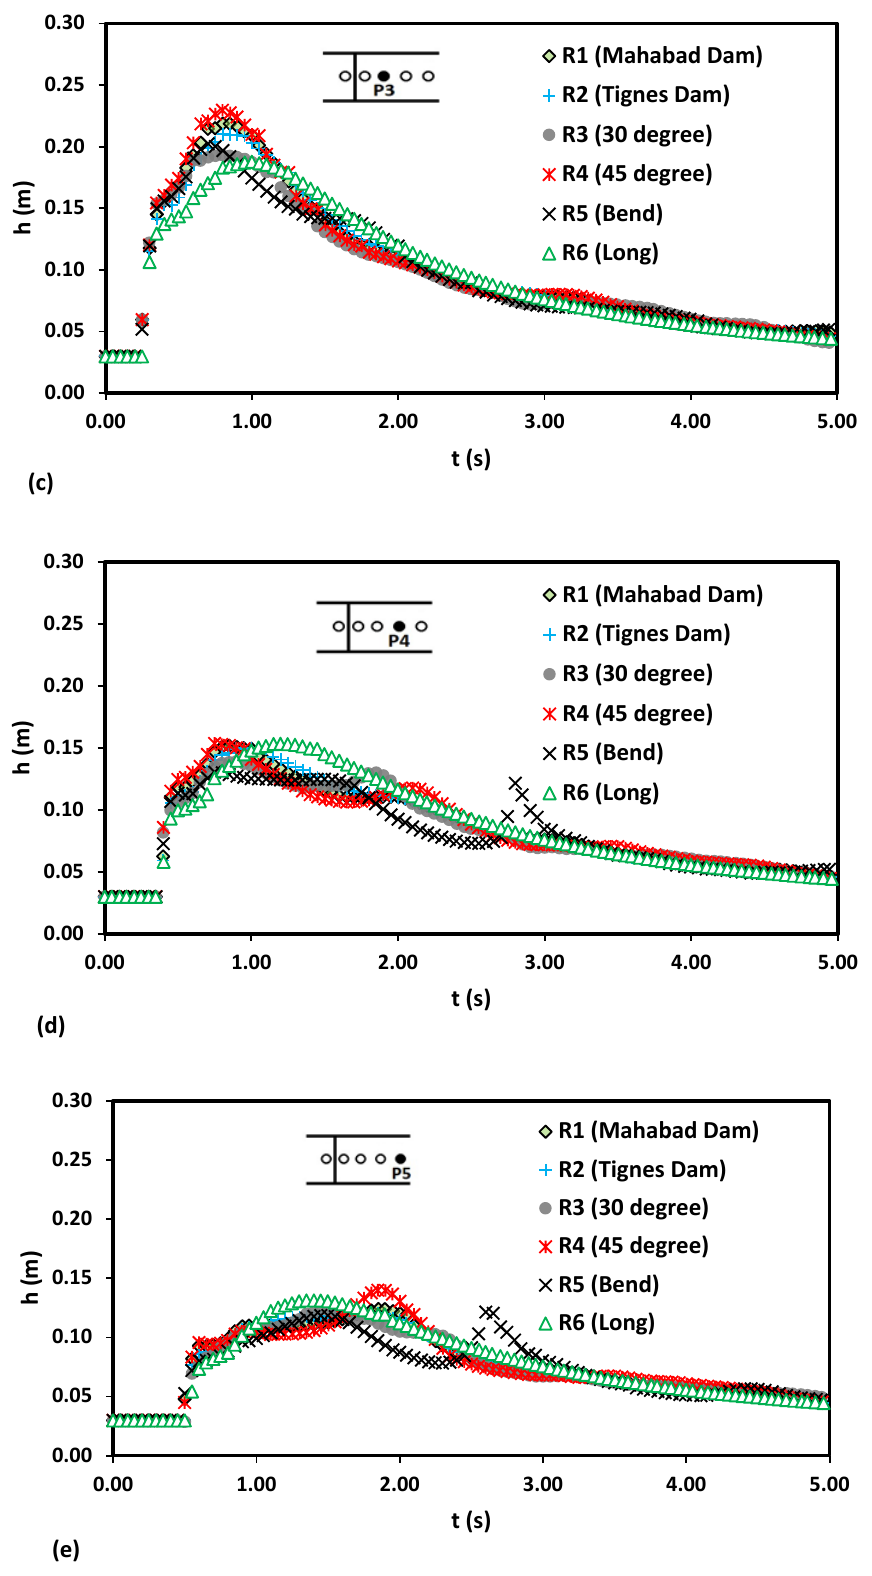
Fig. 9. Water levels at five points (i.e.,